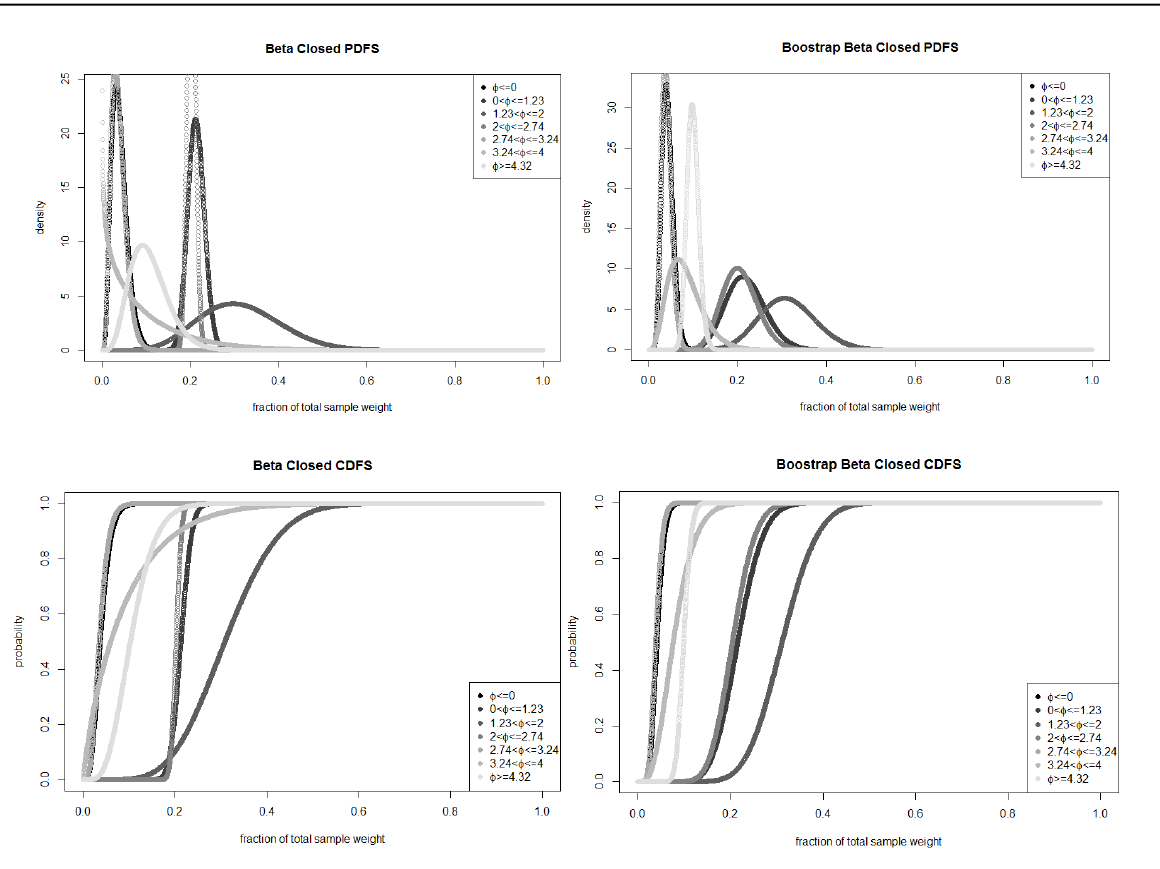
Figure 5. Closed design setting—beta distributions of original samples along with bootstrap distributions.